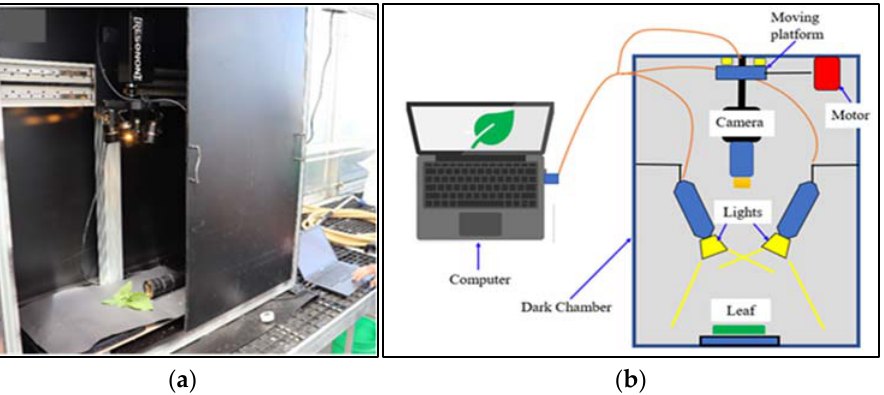
Figure 2. Hyperspectral camera: ( a ) HSI system (camera: Pika XC2, Resonon Inc); ( b ) schematic representation of the HSI scanning system.